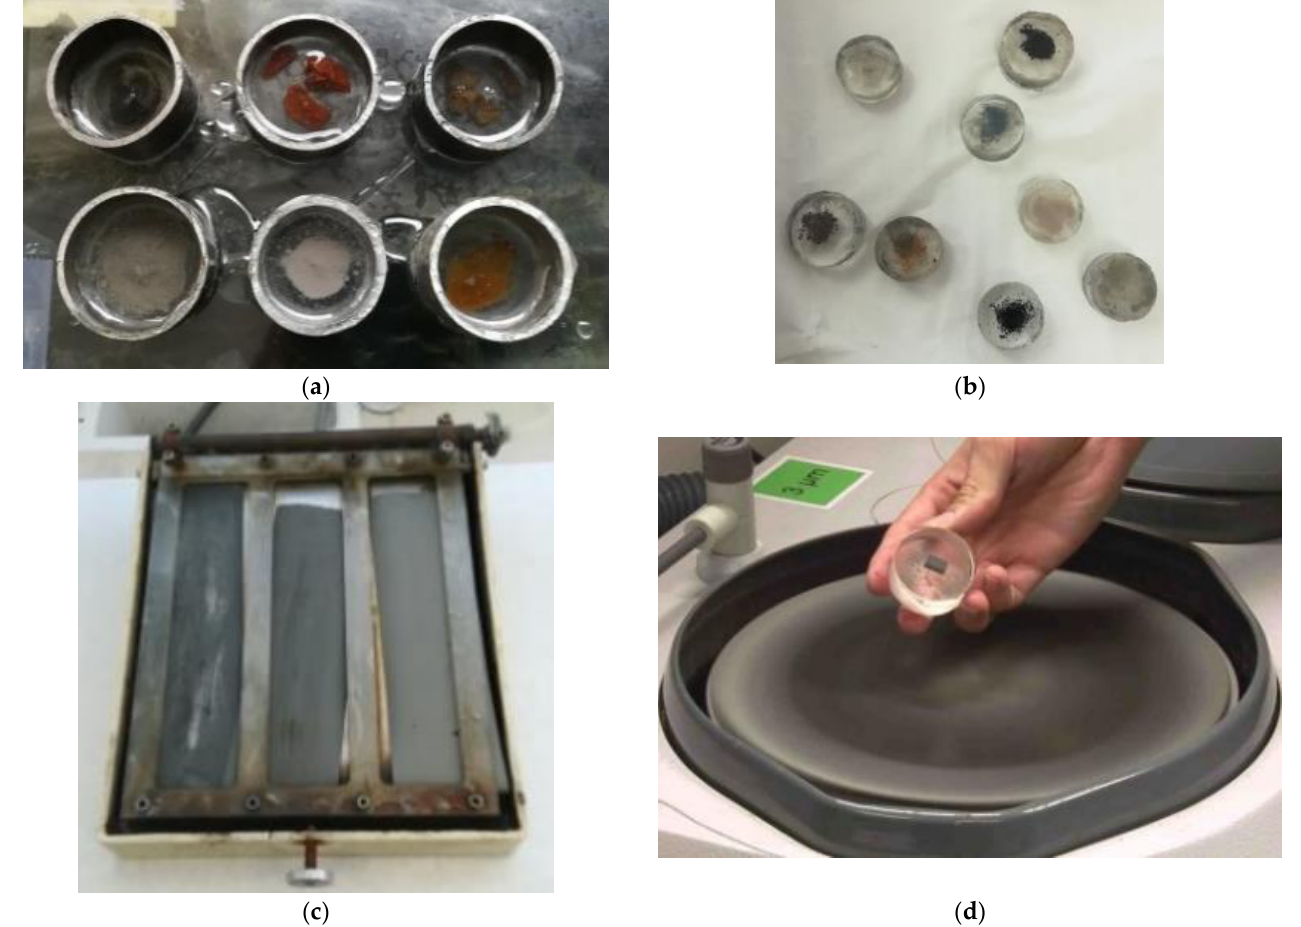
Figure 3. Optical microscopy sample preparation. ( a , b ) Preparation samples for the metallographic bench, ( c ) roughing paper, ( d ) polishing machine.